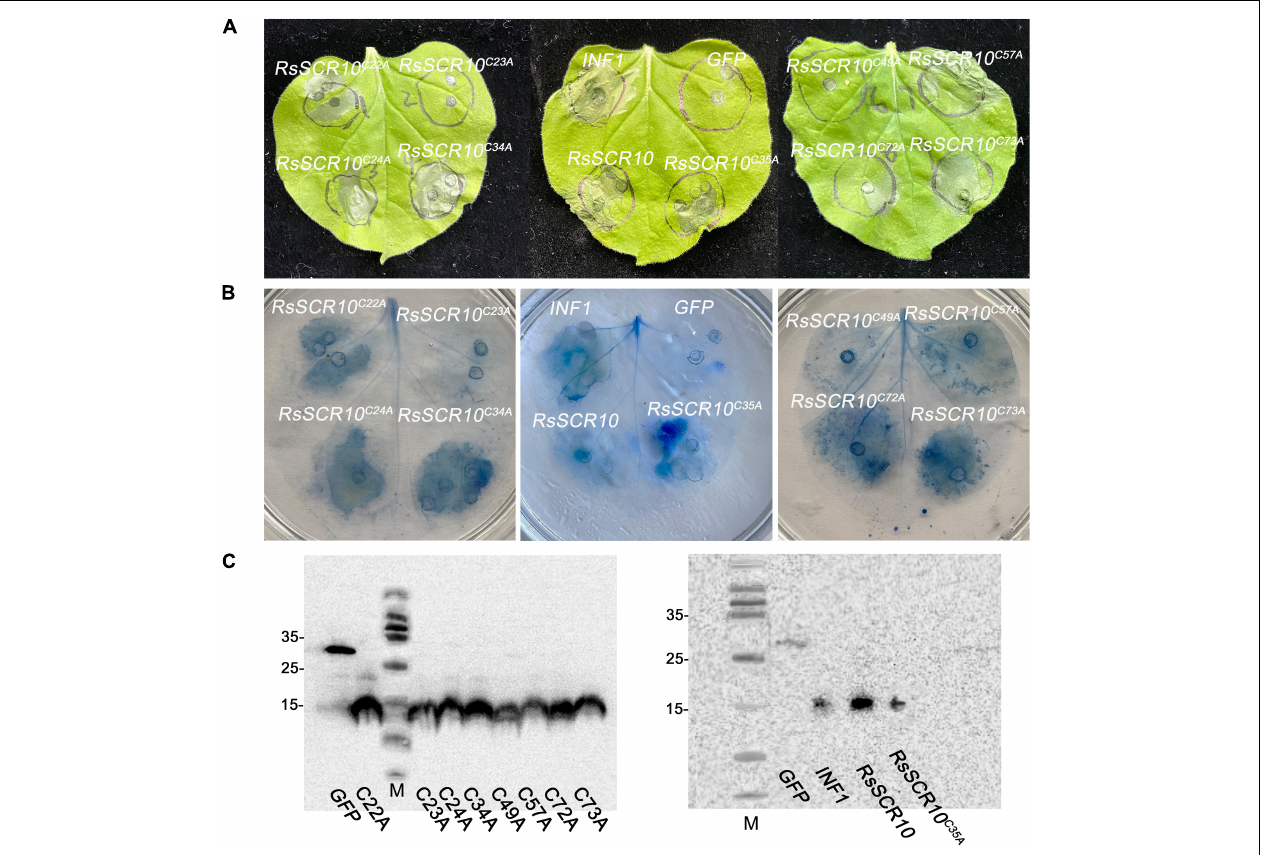
FIGURE 4 | Two cysteine residues of RsSCR10 are required to induce cell death. (A) Expression of RsSCR10 and its mutants constructs in N. benthamiana by agroinfiltration. Typical symptoms were photographed at 4 days post-infiltration (dpi). (B) Trypan blue staining of N. benthamiana leaves. (C) Expression of mutant proteins in infiltrated leaves detected by Western blotting. GFP and INF1 were used as negative and positive controls, respectively. Typical symptoms were photographed at 4 dpi. Data are means from three independent experiments.